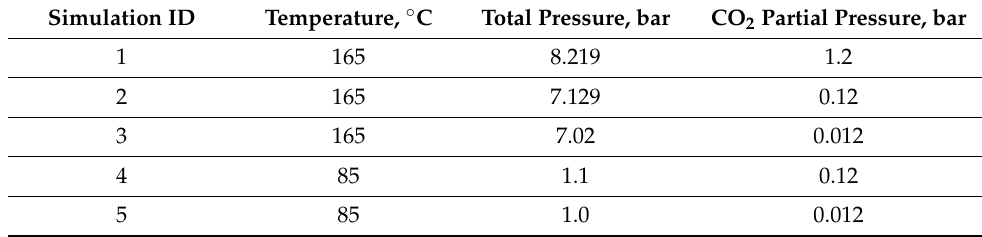
Table 5. The list of geochemical simulations performed for Campanian Ignimbrite